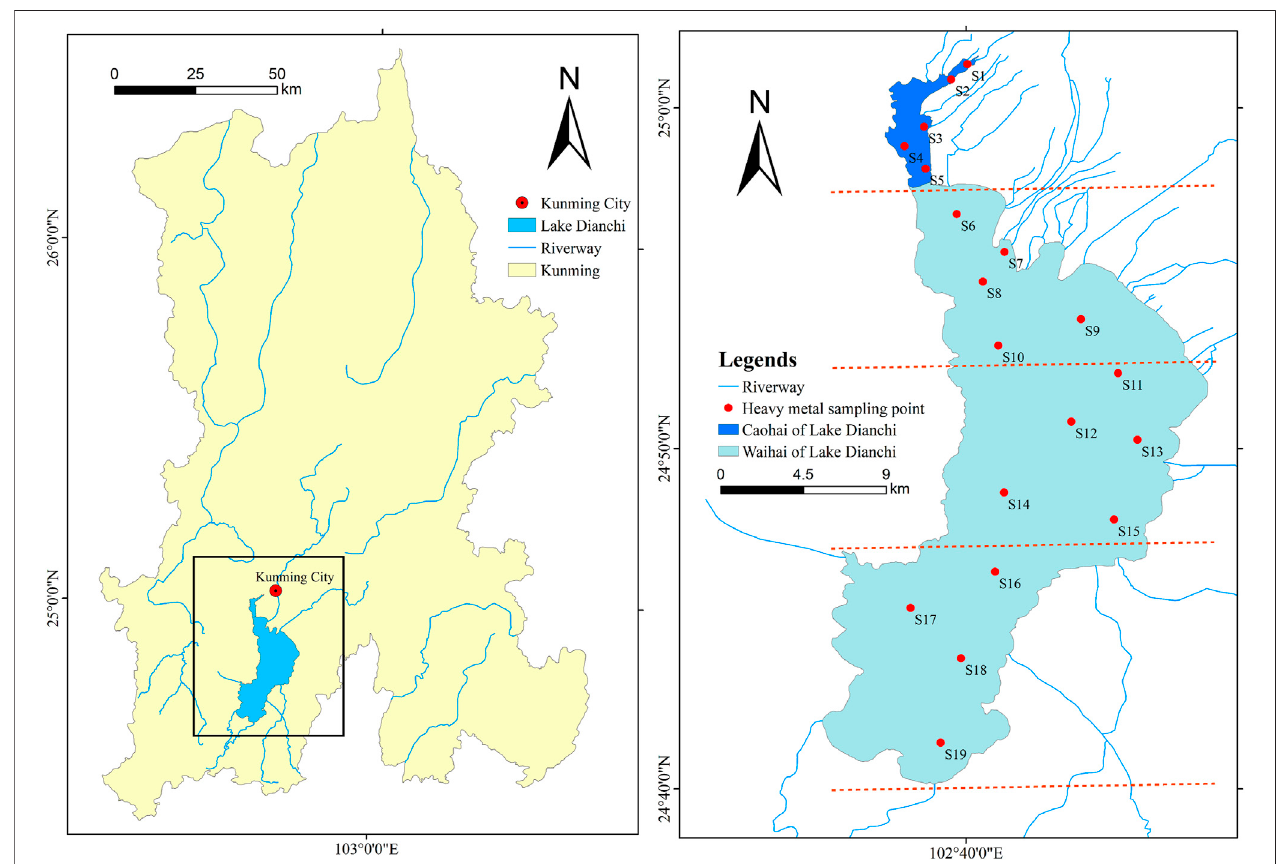
FIGURE 1 | Location of Lake Dianchi and sampling sites in the study area: S1 – S5 in Caohai of Lake Dianchi, S6 – S10 in Northern Waihai, S11 – S15 in Central Waihai, and S16 – S19 in Southern Waihai.